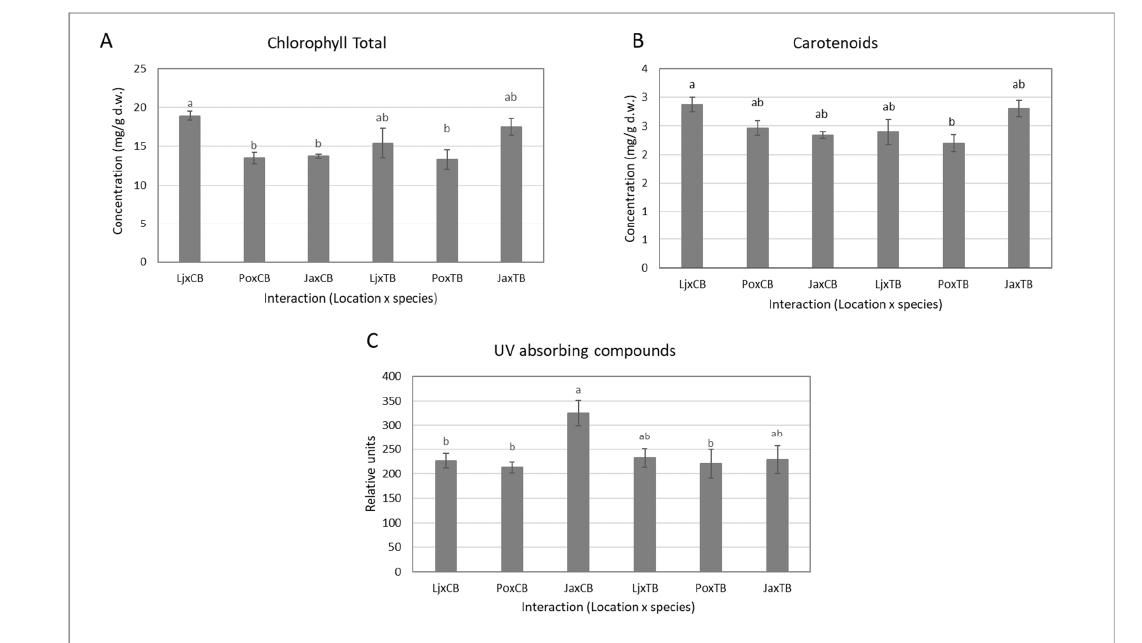
Figure 1. The effect of growth location on the concentrations of chlorophylls ( A ), carotenoids ( B ) and UV-absorbing compounds ( C ) in leaves of CB and TB. Data are means ± standard deviation. Means followed by different letters are significantly different at p < 0.05 (n = 8).